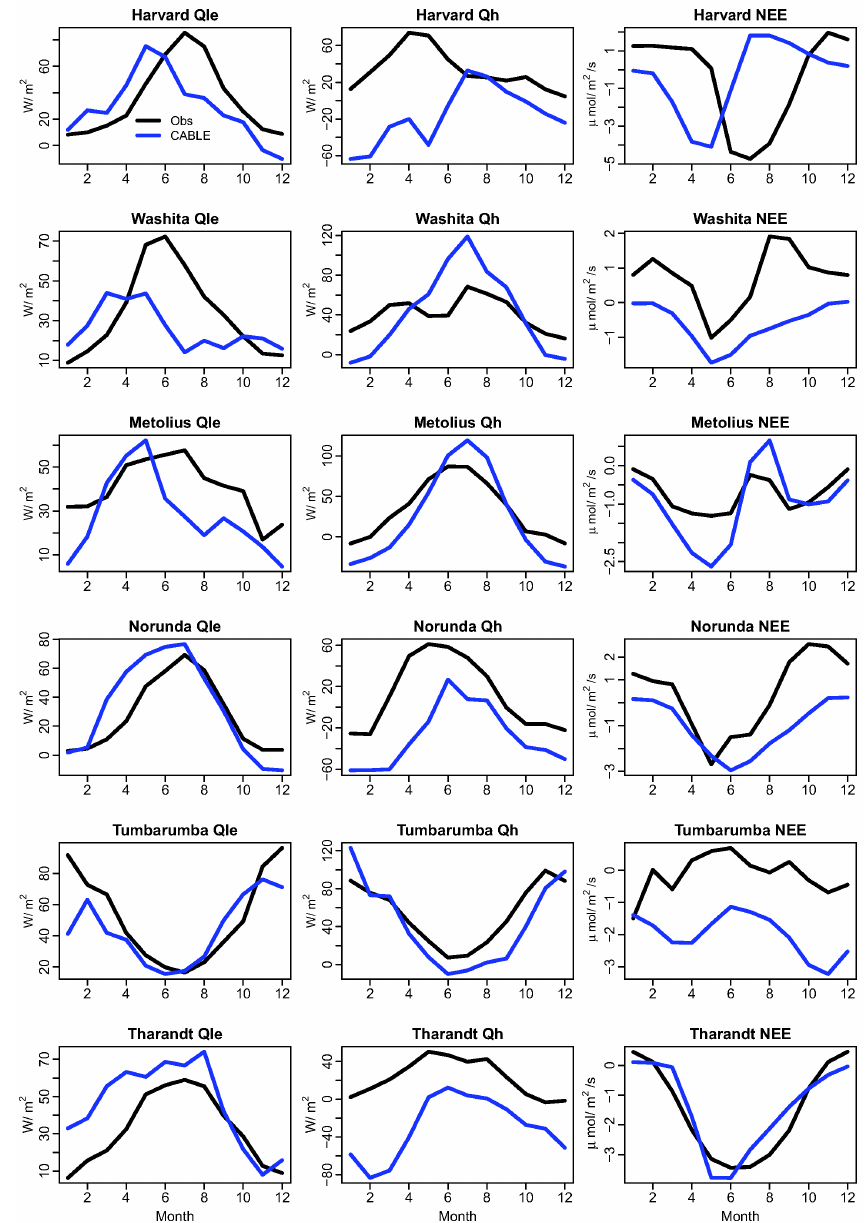
Fig. 1. Seasonal climatology observed and simulated for the six locations detailed in Table 1. The first column is the latent heat flux (Wm − 2 ), the second column is the sensible heat flux (Wm − 2 ), and the third column is the net ecosystem exchange of CO 2 (µmolm − 2 s − 1